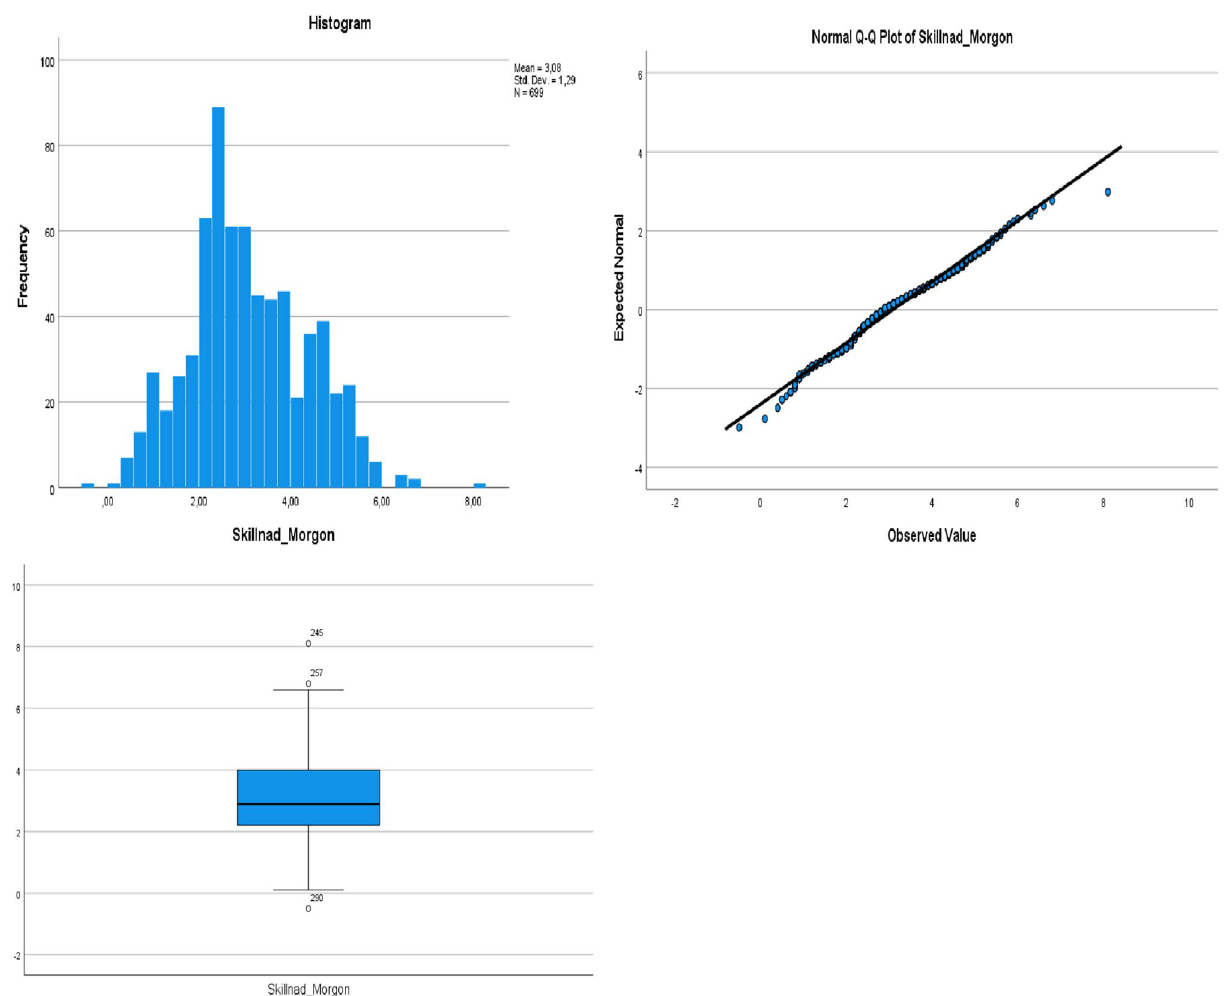
Fig. 1 Histogram, Q-Q plot, and box plot for ID 1–12